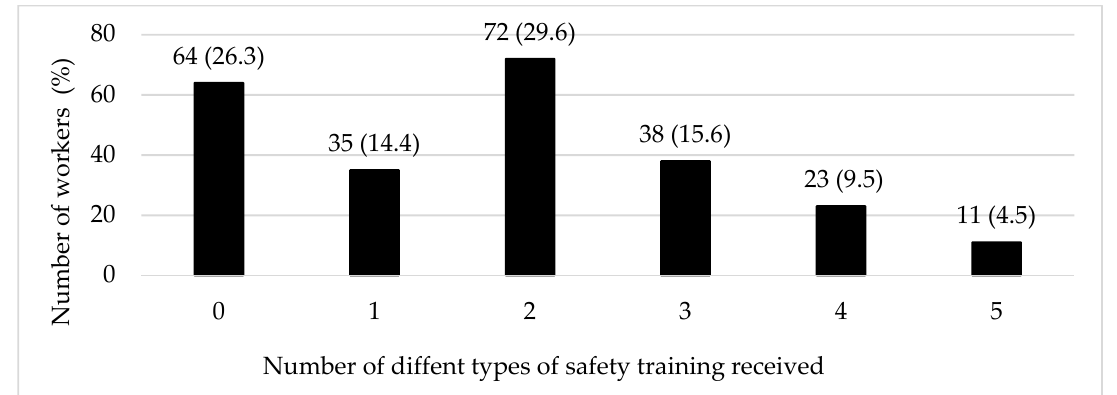
Figure 2. Distribution of feedyard workers by the number of different types of safety training received.